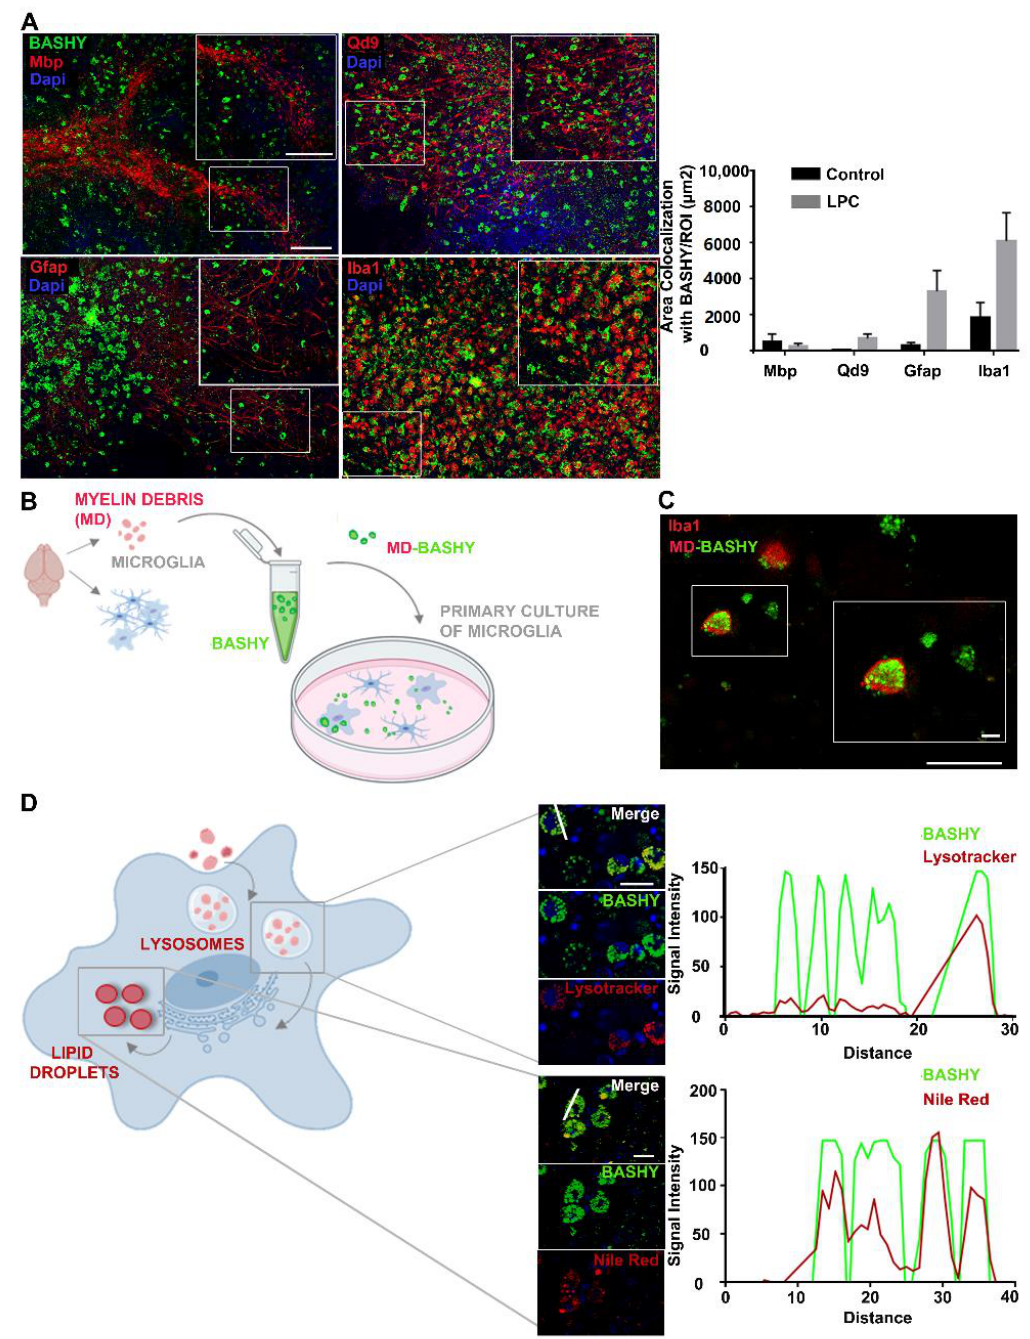
Figure 2. BASHY targets myelin-phagocytosing macrophages/microglia and images of myelin intracellular degradation pathway. ( A ) Representative images from the cerebellar white matter of organotypic cerebellar slice cultures (OCSCs) and respective quantitative analysis of BASHY (green) co-localization with mature oligodendrocytes/intact myelin (Mbp, red), degenerated myelin (Qd9, red), astrocytes (Gfap, red), and microglia/macrophages (Iba1, red) 48 h post-LPC induction (magnification 20X). Scale bar equals 120 microns. Results are mean ± SEM. Data are representative of four independent experiments. In total, 17 to 25 z-planes were analyzed per field. ( B ) Schematic representation of BASHY staining of myelin debris and posterior incubation in primary cultured microglia. Myelin debris was collected from P10 rats and stained with BASHY probe. At the same time, microglia were isolated from mixed glial cultures prepared from P10 rats and cultured for another 24 h, after which, they were incubated with the previously stained BASHY-labeled myelin debris (MD-BASHY). ( C ) Representative images of MD-BASHY (green) in culture (scale bar equals 120 microns) and internalized by microglia (Iba1, red) (scale bar equals 20 microns). ( D ) After inter- nalization, excessive myelin-derived cholesterol aggregates accumulate inside lysosomes before be- ing transported to the endoplasmic reticulum and finally stored into lipid droplets. Schematic figure of myelin intracellular degradation pathway and representative images of BASHY (green) co-local- ization with lysosomes (Lysotracker, red; upper panel) and lipid droplets (Nile Red, red; lower panel) with specific fluorescence signal intensity profiles of the identified region (white line). Scale bar equals 20 microns. Gfap, glial fibrillar acidic protein; Mbp, myelin basic protein; Iba1, ionized calcium binding adaptor molecule 1 (created with Biorender.com).